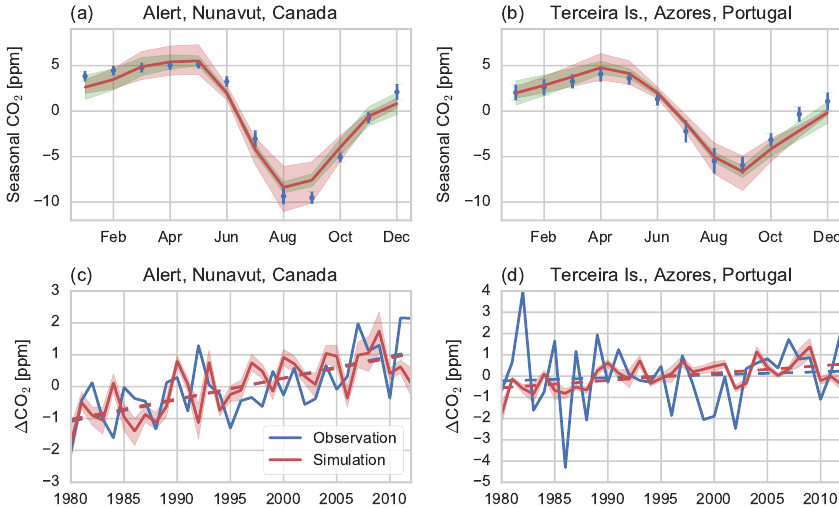
Figure 8. (a, b) Seasonal cycle averaged from 1980 to 2013 at two measurement sites (GLOBALVIEW-CO2, 2013) (blue) compared to the median values of the M net , net ensemble, with 90% confidence interval shaded in red. The standard deviations of the seasonal average are indicated with error bars for the measurements and green shading for the simulations. In panels (c, d) the growth in the amplitude of atmospheric CO 2 for the same two measurement sites (GLOBALVIEW-CO2, 2013) (blue) is compared to the median of the model ensemble, with the 90% confidence interval shaded in red. A linear fit indicated by dashed lines is included. The CO 2 concentration at a given site and time is computed with the TM2 transport model using simulated net land–atmosphere fluxes for each ensemble member and ocean– atmosphere fluxes from the Bern3D ocean model (Battaglia and Joos, 2018). The seasonal cycle of CO 2 is dominated by fluxes from the land – in particular, the Northern